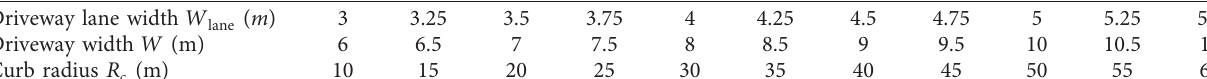
Table 2: Alternative values of driveway width and curb radius.